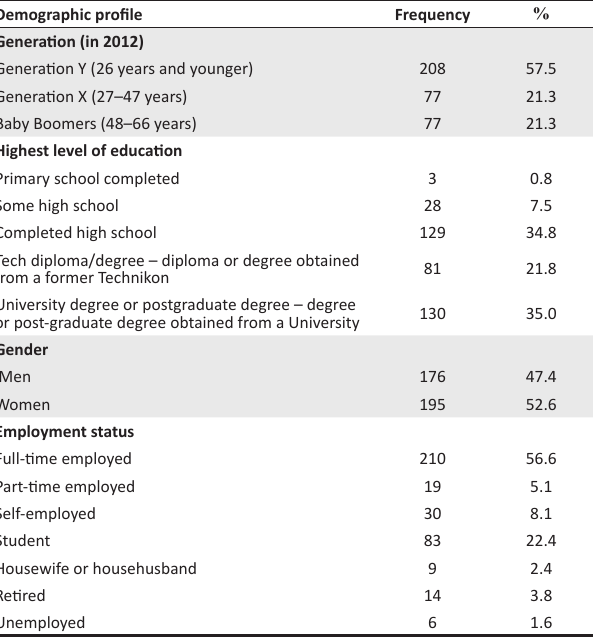
TABLE 1: Demographic profile of respondents.